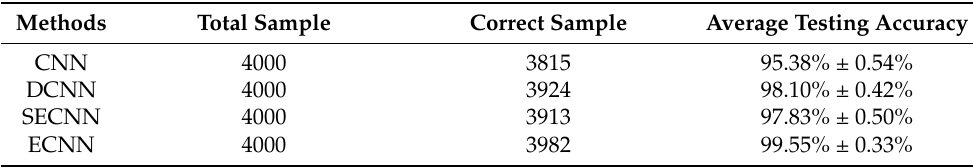
Table 8. Diagnosis results of the ten trials using different